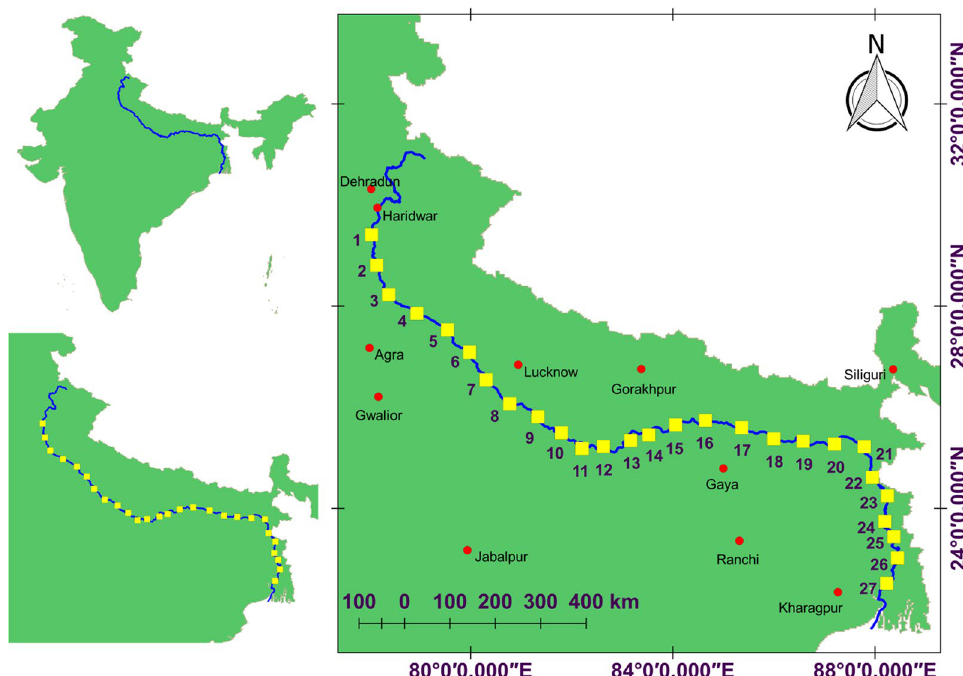
Fig. 1 Location of 27 spider sampling sites studied along the Ganga River,